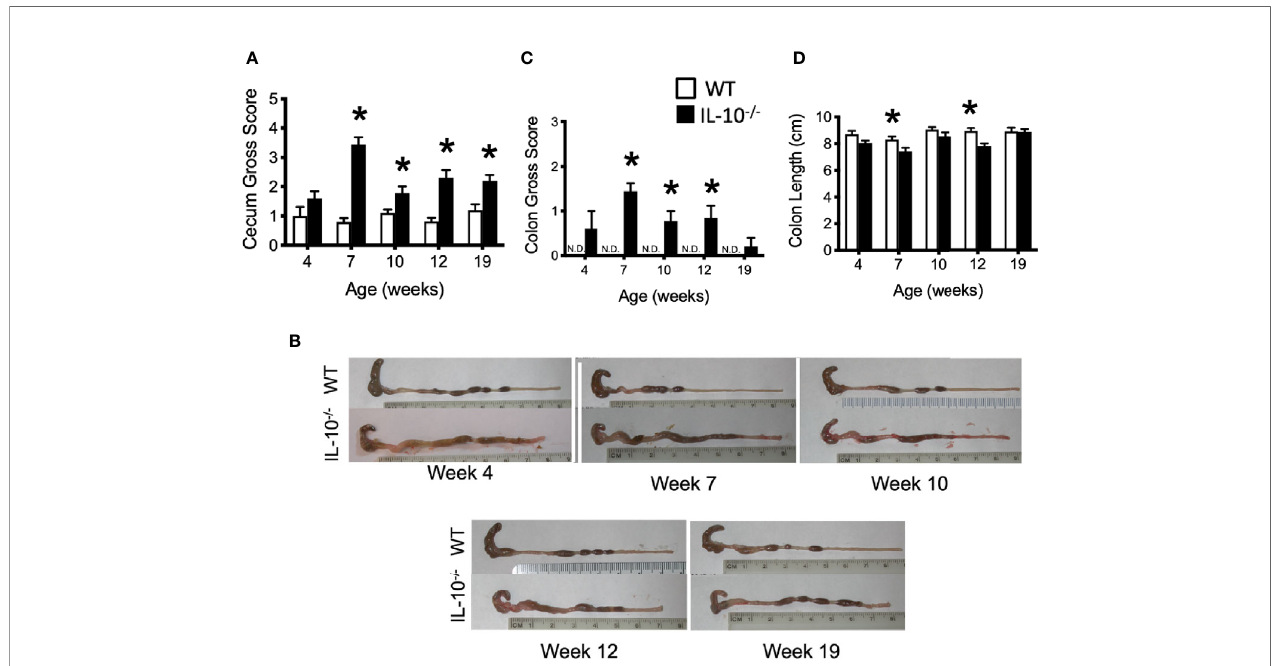
FIGURE 3 | Macroscopic evaluation of GI tissue from WT and IL-10 -/- mice. Macroscopic lesion scores from WT (white bars) and IL-10 -/- (black bars) mice for the cecum (A) and colon (C) . Representative photomicrograph depicting colons from WT and IL-10 -/- mice at each time point as indicated (B) . (D) Graphical comparison of colon lengths. Data are presented as mean ± SEM. * = p ≤ 0.05 comparing WT and IL-10 -/- for each time point. The number of mice used for each strain at each time point varied as follows: at 4 weeks of age, n = 5; at 7 weeks of age, n = 10; at 10 weeks of age, n = 9; at 12 weeks of age, n = 13; at 19 weeks of age, n = 5.